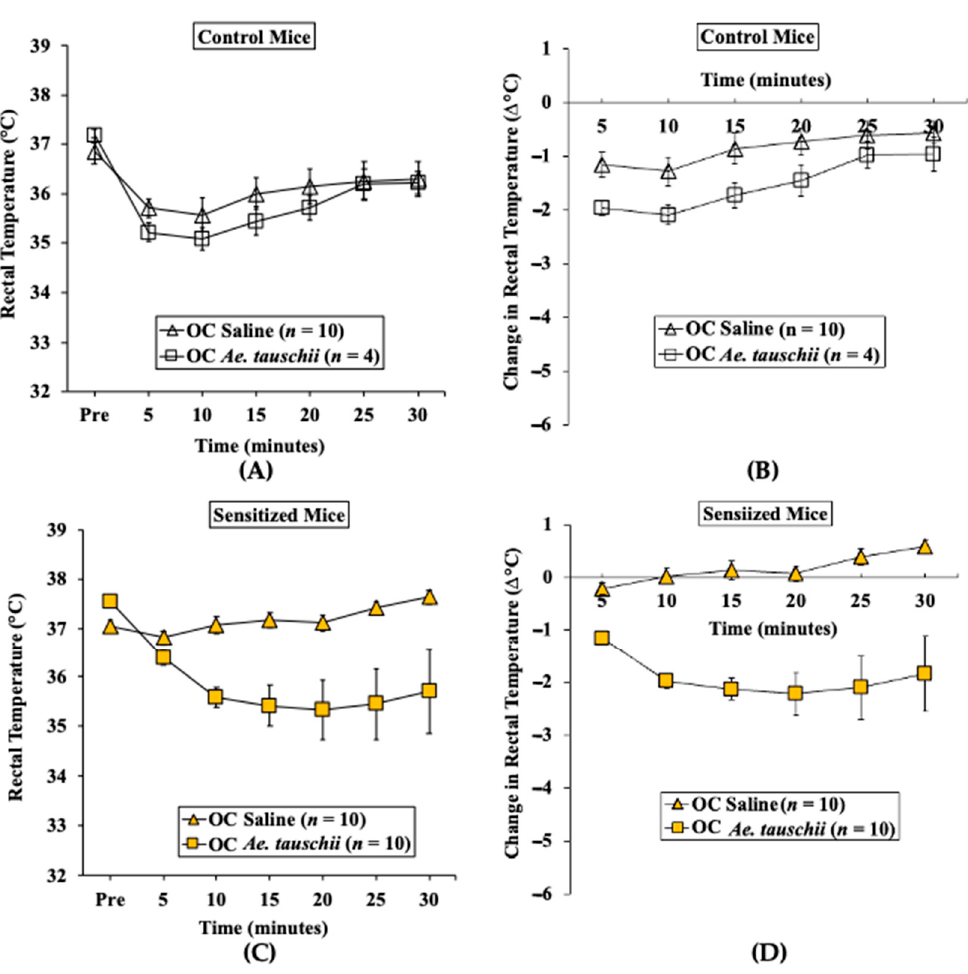
Figure 8. Transdermal sensitization with SSPE is sufficient for eliciting oral anaphylaxis using Aegilops tauschii SSPE in Balb/c mice. Mice were sensitized and orally challenged with Ae. tauschii SSPE or with saline as described in Materials and Methods. ( A ) Actual rectal temperature at indicated time points in control mice challenged with Ae. tauschii SSPE or saline. ( B ) Change in rectal temperature at indicated time points in control mice challenged with Ae. tauschii SSPE or saline. ( C ) Actual rectal temperatures at indicated time points in SSPE-sensitized mice challenged with Ae. tauschii SSPE or saline. ( D ) Change in rectal temperature at indicated time points in SSPE-sensitized mice challenged with Ae. tauschii SSPE or saline. Ab: antibody, OC: oral challenge, SSPE: salt-soluble protein extract, n : number of mice